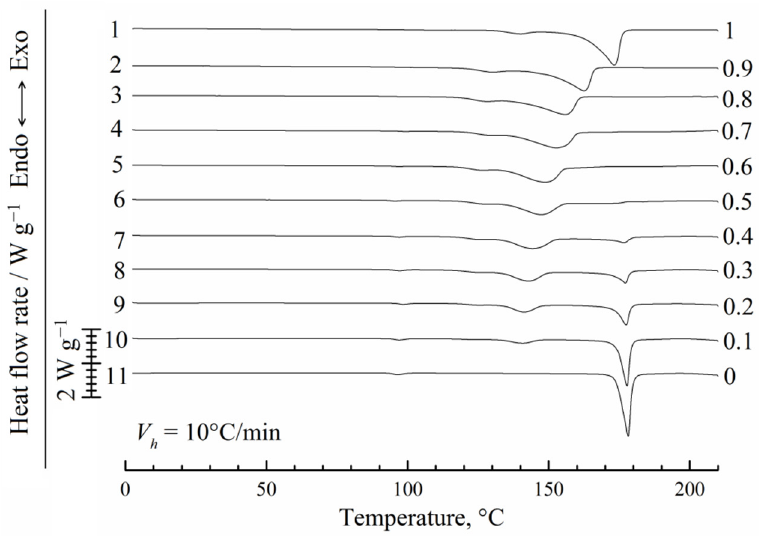
Figure 3. DSC curves of 1st heating for PVDF, camphor, and their mixtures of different compositions. The heating rate is V h = 10 °C/min. Mass fractions of the polymer are shown to the right of the curves, which are arbitrarily shifted in the vertical direction.